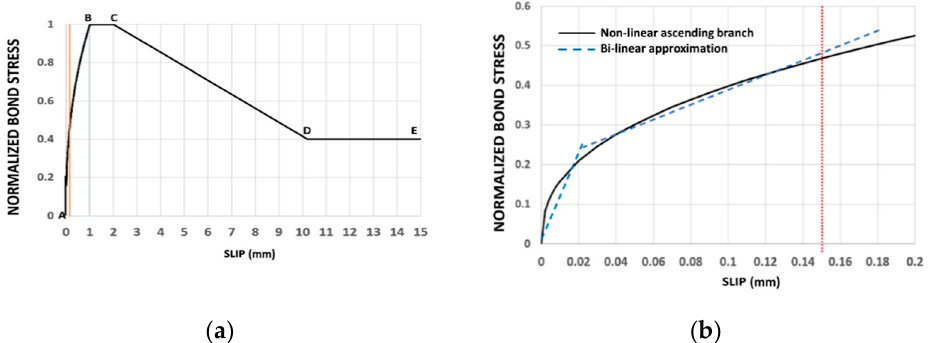
Figure 1. The Fib Model Code [17] bond-slip relationship. ( a ) The complete bond-slip relationship; ( b ) view at the slip range S < 0.15 mm.